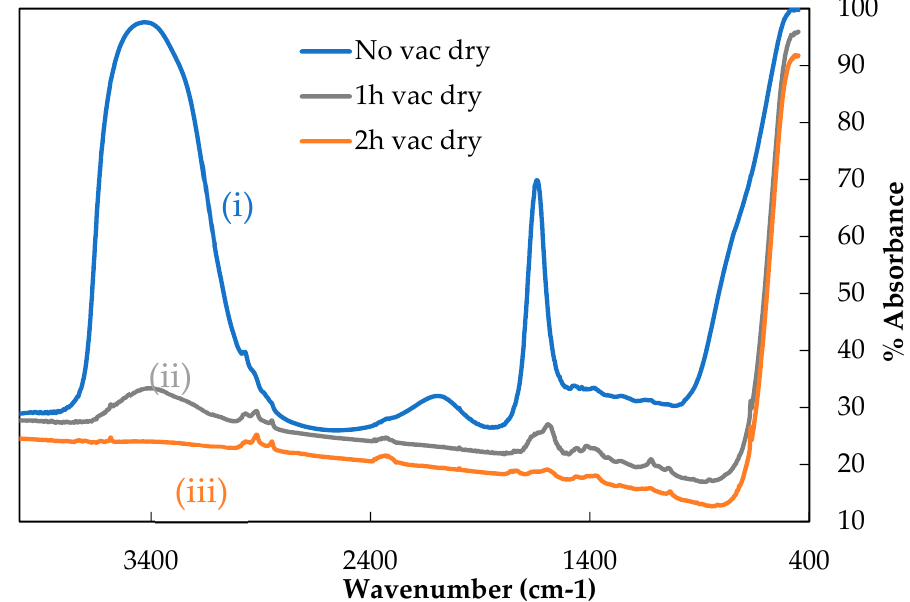
Figure 3. IR plots of bare fibre samples heat treated to 450 °C for 15 min following vacuum drying for (i) zero, (ii) 1 or (iii) 2 h. Curves (ii) and (iii) have shifted down the y-axis for clarity; uncorrected curves showed 100 % absorbance at 400 cm − 1 .